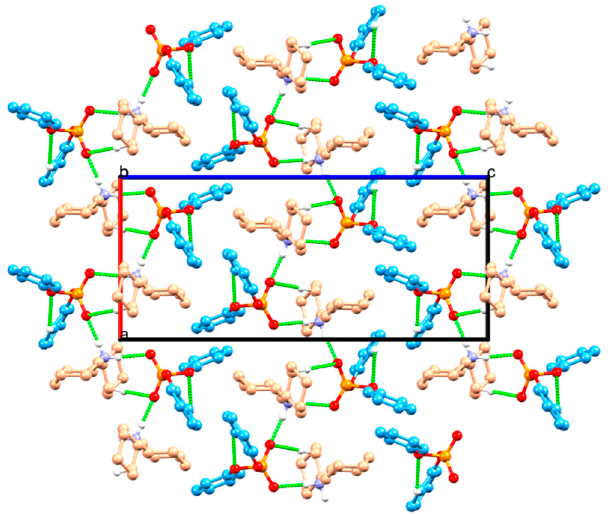
Figure 3. The molecular interactions of [(C 6 H 11 ) 2 NH 2 ][(C 6 H 5 O) 2 P(O)(O)] viewed along the b direction. Intra and intermolecular C–H…O interactions are shown along with the strong N–H…O intermolecular interactions. Hydrogen atoms not involved in the interactions are omitted for the sake of clarity, and the hydrogen bonds are shown as dashed lines. Color keys are red O, orange P, blue N; the C atoms of cation and anion components are shown as gold-orange and light blue colors, respectively.